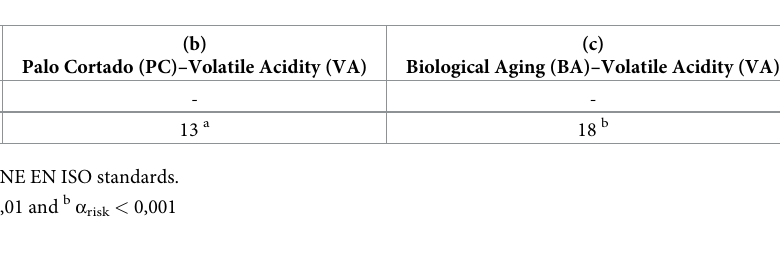
Table 3. Verification test of the sensory classification process of palo cortado (PC), biological aging (BA) and volatile acidity (VA) set of wines by tasting panel (N = 20). N = 20 panelists